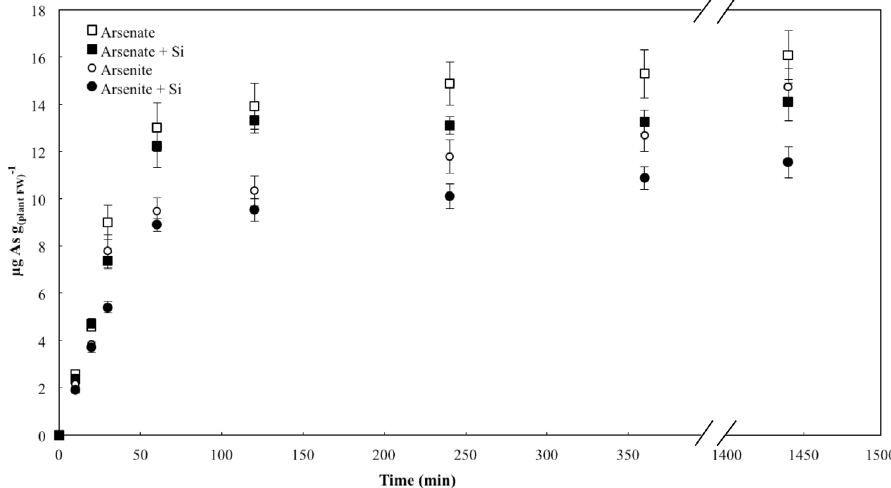
Fig. 3: Uptake of As by lettuce over 24 h from nutrient medium containing 1 μM arsenite or arsenate with or without 1 mM potassium silicate; n = 5, ±SE.